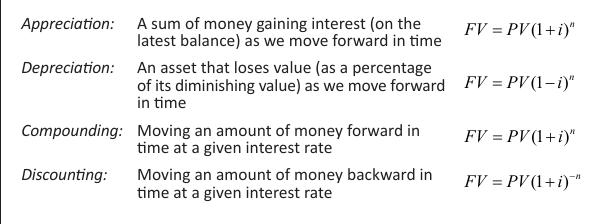
FIGURE 5: Definitions of